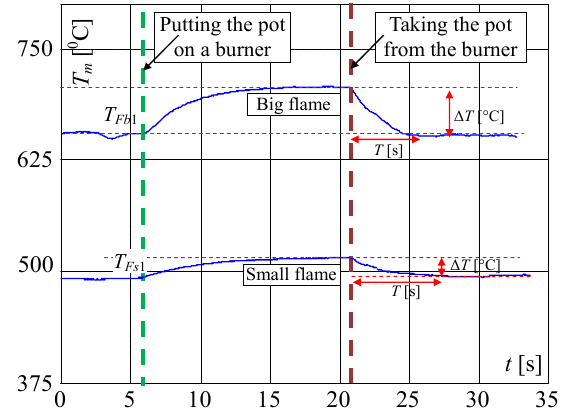
Figure 7. Temperature changes measured by a factory mounted thermocouple when putting the pot on and removing it from the burner, when the flame is big (valve on max.) and small (valve on min.). In Figure 8, the same but enlarged curves are presented. When the flame is high (valve open on maximum) and the pot is not on the burner, the measured temperature is T Fb 1 = 655 °C (Figure 8a). If the pot is placed on the burner, the temperature increased to about 695 °C in the time T = 5 s ( Δ T = 40 °C) and within the next 5 s to 705 °C. To achieve the goal of the research, the measurement of the temperature change when the pot is taken away from the burner is the most important. In this case, as registered, the temperature decreased in the time of T = 5 s from 705 to 655 °C i.e., Δ T = 50 °C. In the case of a small flame (Figure 7) i.e., when the valve is open on minimum, the temperature increased in 5s from 495 to 515 °C i.e., only of Δ T = 20 °C and decreased from 520 to 502 °C i.e., only of Δ T = 18 °C, also in T = 5 s. Such rather small temperature changes may be too difficult to recognize automatically that the pot is absent, using only a factory-mounted thermocouple.